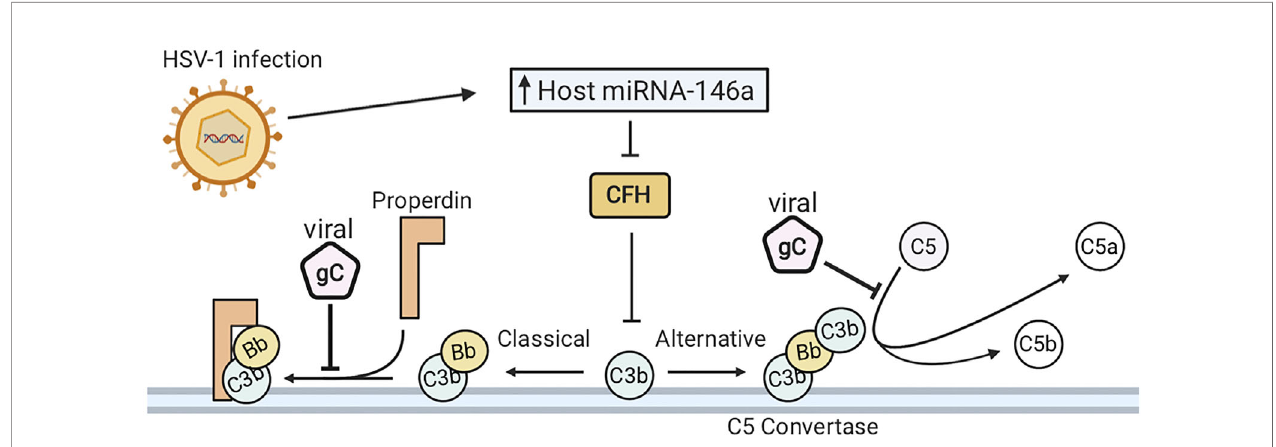
FIGURE 5 | HSV – 1 infection evades the complement system. (A) HSV – 1 glycoprotein C (gC) binds complement component C3b. This inhibits the interaction of C5 and properdin with C3b, blocking activation of both the classical and alternative complement pathways. HSV – 1 downregulates complement factor H (CFH), which is concurrent with elevated expression of host microRNA (miRNA) –